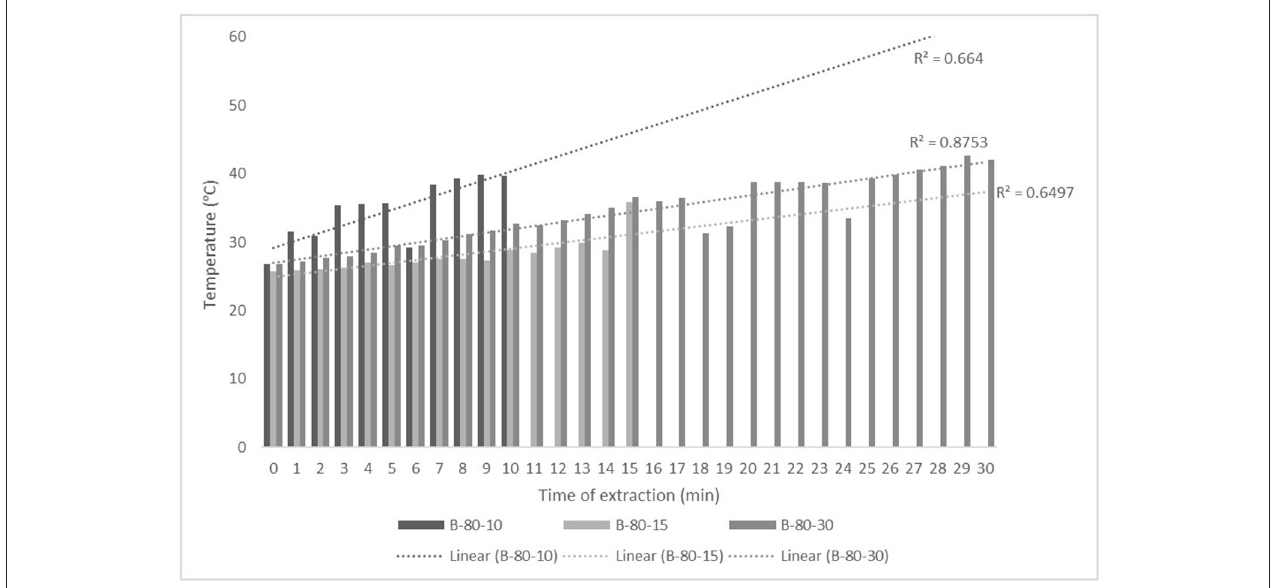
FIGURE 4 | Temperature ( ◦ C) of nettle extracts with 80% v/v ethanol during the UAE in the ultrasonic bath for 10min (B-80-10), 15min (B-80-15), and 30min